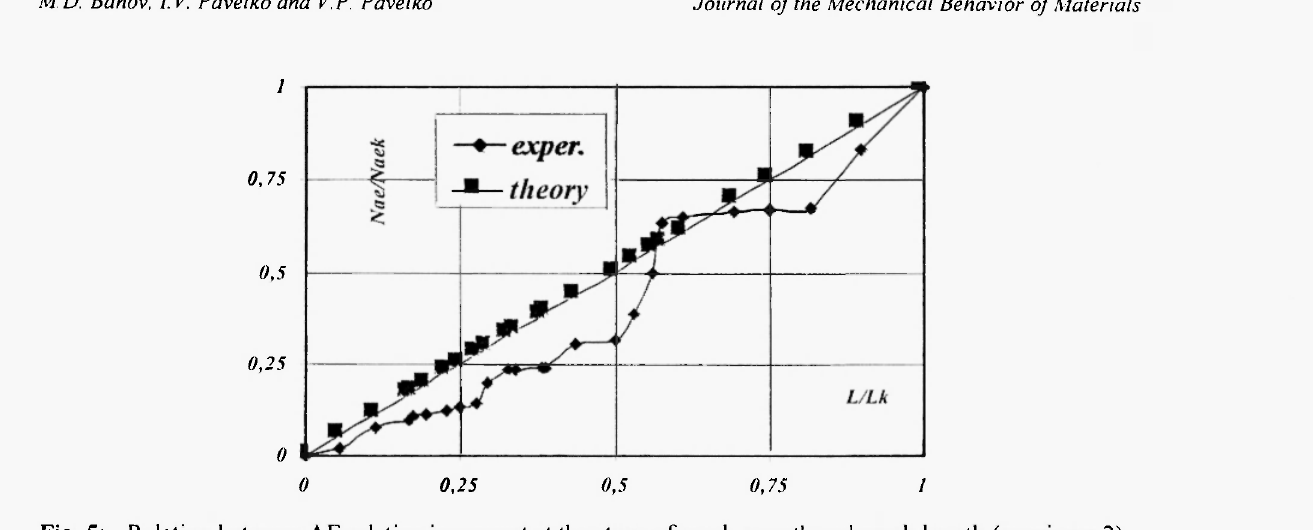
Fig. 5: Relation between AE relative increment at the stage of crack growth and crack length (specimen 2).